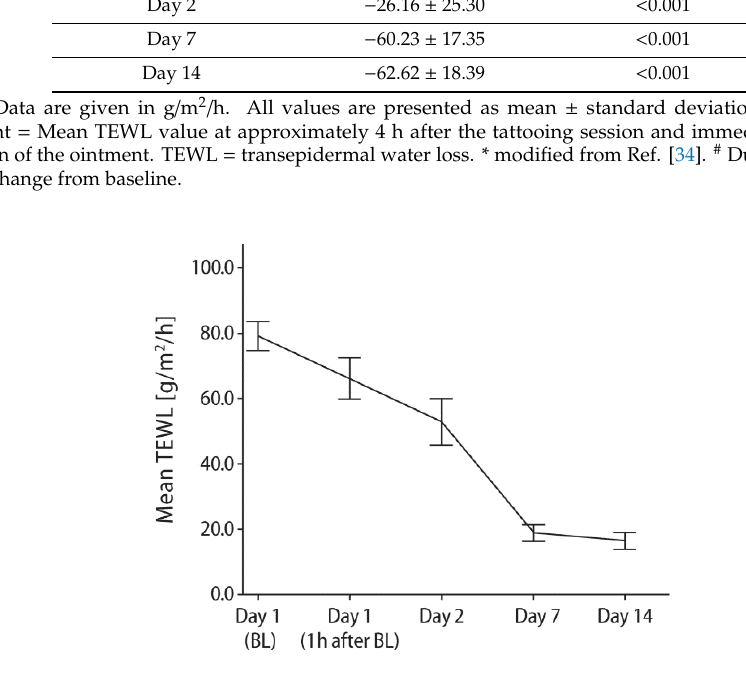
Figure 4. Mean ( ± 95% confidence interval) TEWL following topical application of an ointment Figure 4. Mean (±95% confidence interval) TEWL following topical application of an ointment containing 5% dexpanthenol on freshly tattooed skin 4–8 times daily for 14 days. BL = containing 5% dexpanthenol on freshly tattooed skin 4 – 8 times daily for 14 days. BL = Baseline assessment at approximately 4 h after the tattooing session and immediately before treatment initiation. TEWL = transepidermal water loss. From Ref. [34] with kind permission from Wounds International (www.woundsinternational.com).